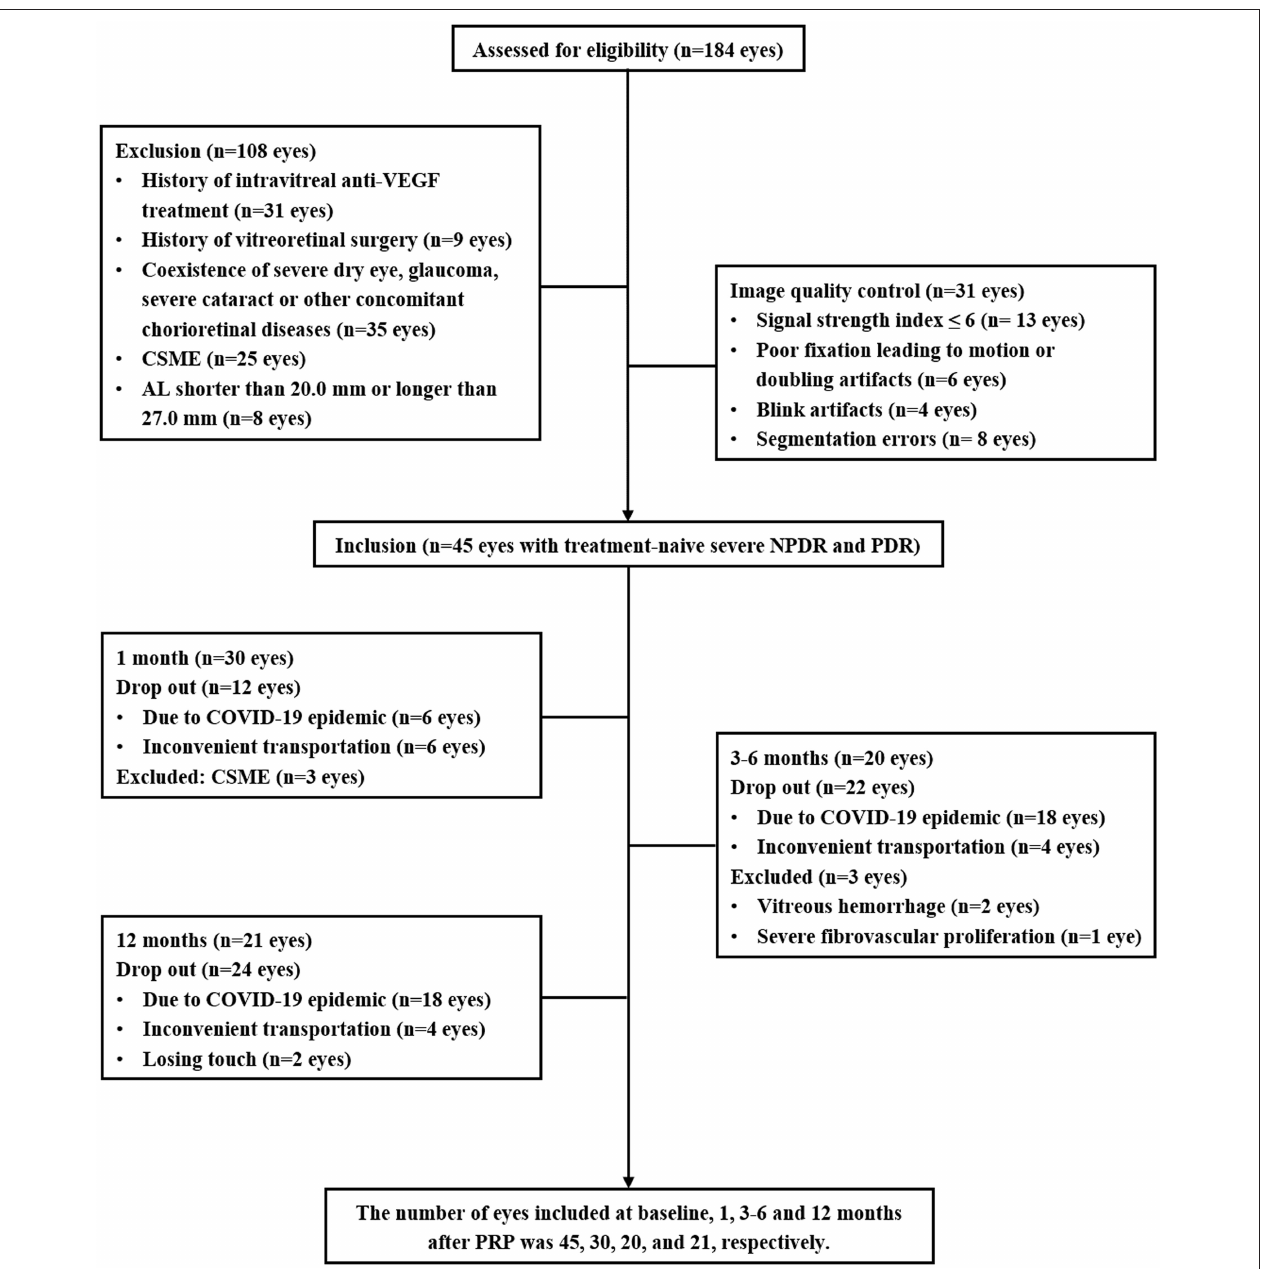
FIGURE 1 | Flowchart detailing enrollment and follow-up of the subjects in the